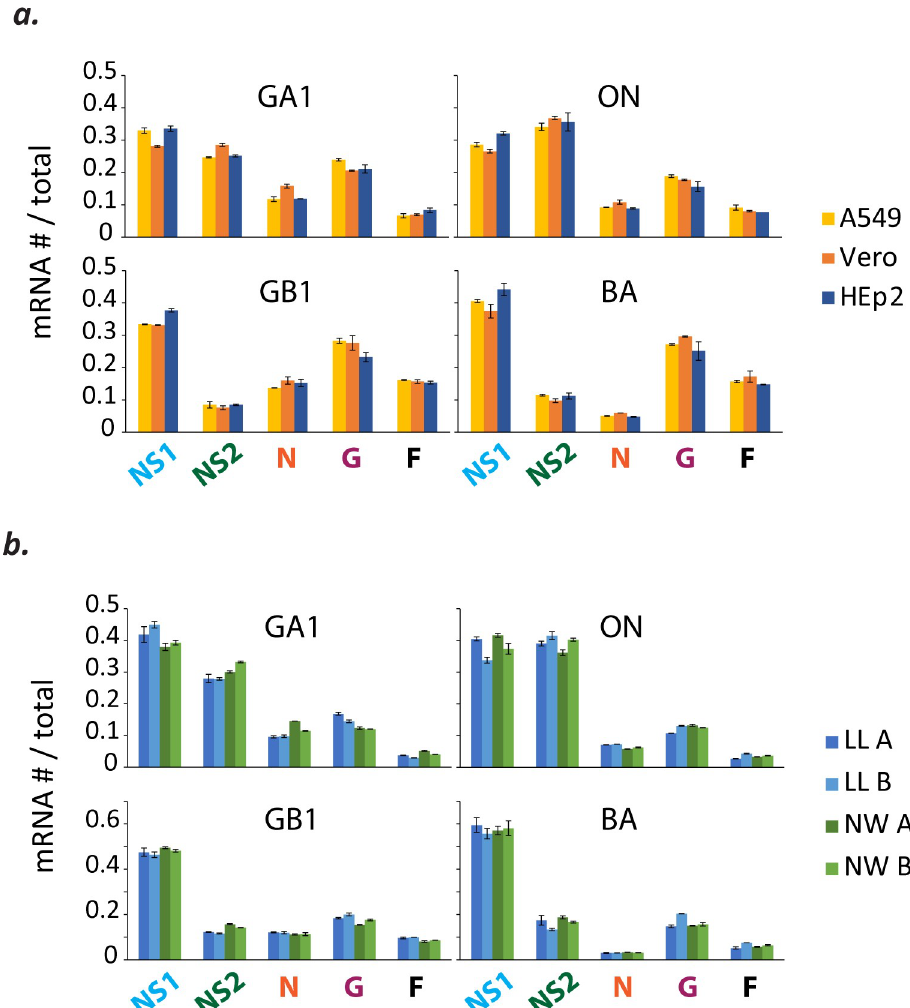
Fig 4. Relative mRNA levels are comparable in different cell lines and in nasal wash and lung lavage samples from infected cotton rats. (a) Relative mRNA levels are comparable in different cell lines. Viral mRNA levels were measured from infected A549 (in yellow), Vero (in orange), and HEp-2 (in blue) cell lines (MOI = 0.01) at 24 hours post-infection (pi). Each bar depicts the mean mRNA # / total mRNA # of the indicated species and error bars show the standard deviation (n = 2). For each independent experiment, the mean was calculated from duplicate measurements and used in subsequent calculations. (b) Relative mRNA levels are comparable in lung lavage (LL) and nasal wash (NW) samples from infected cotton rats. Each bar depicts the mean mRNA # / total mRNA # of the indicated species and error bars show the standard deviation calculated from duplicate measurements of the same sample. Results from LL samples collected 4 days pi are shown in blue (cotton rat A = light blue; cotton rat B = dark blue) and NW samples shown in green (cotton rat A = light green; cotton rat B = dark